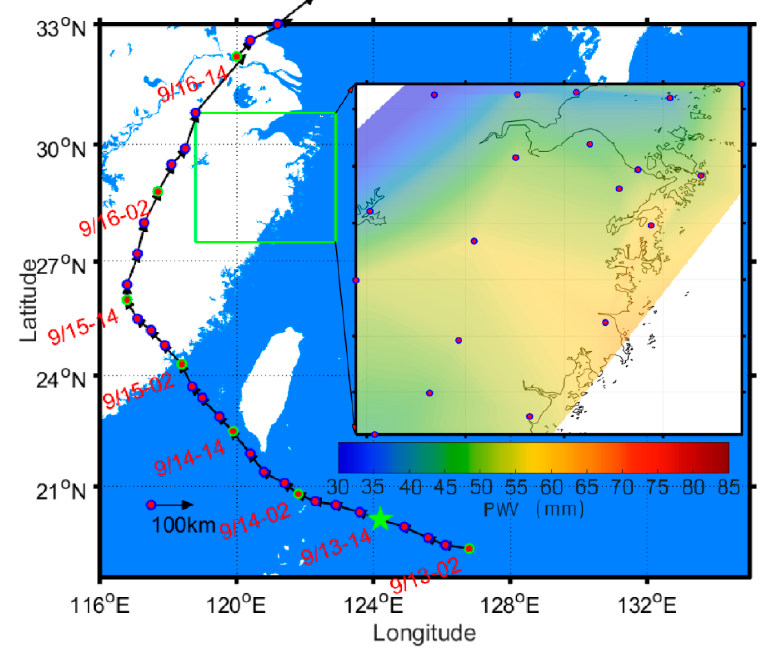
Figure A1. The PWV distribution over Zhejiang province at 14:00 on 13 September 2016.